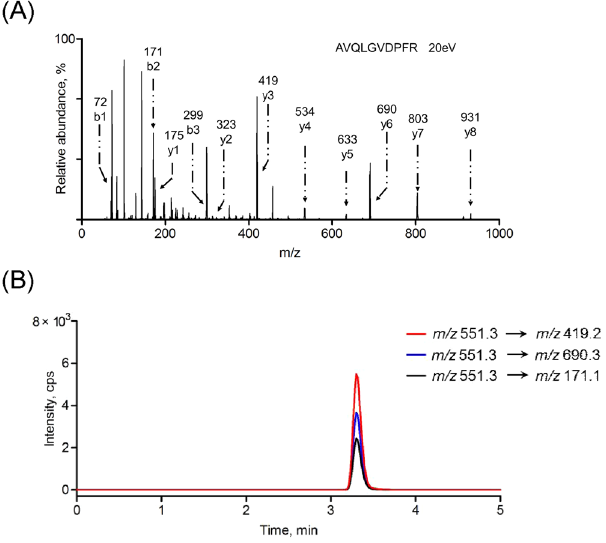
Figure 3. ( A ) Product ion spectrum and ( B ) LC-MS/MS chromatogram of the reporter peptide AVQLGVDPFR. The MRM transitions were m / z 551.3 → m / z 690.3, m / z 551.3 → m / z 171.1 and m / z 551.3 → m / z